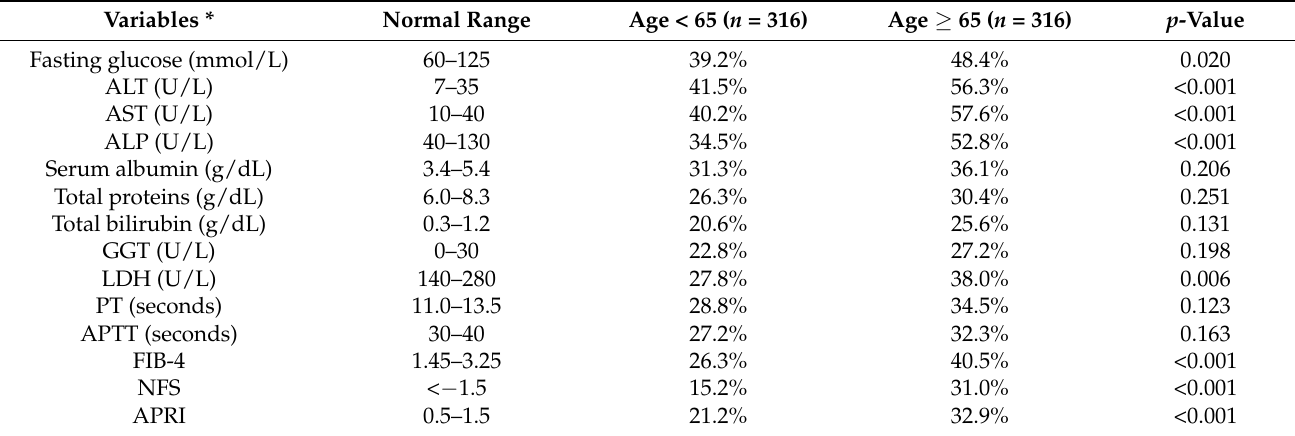
Table 3. Comparison of liver studies at admission between cases and